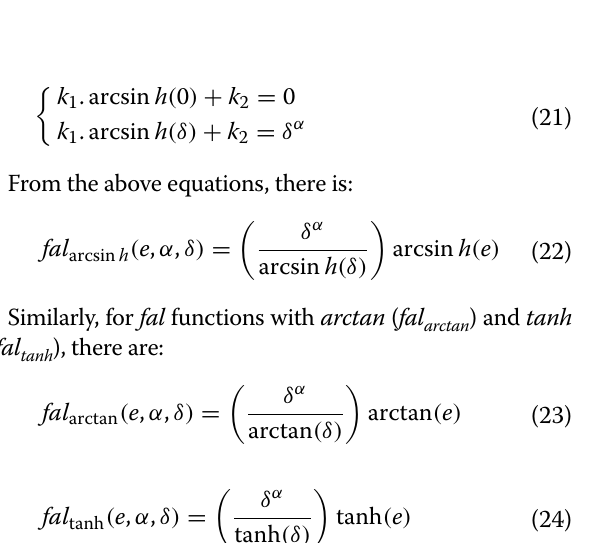
Fig. 7 Block diagram of the